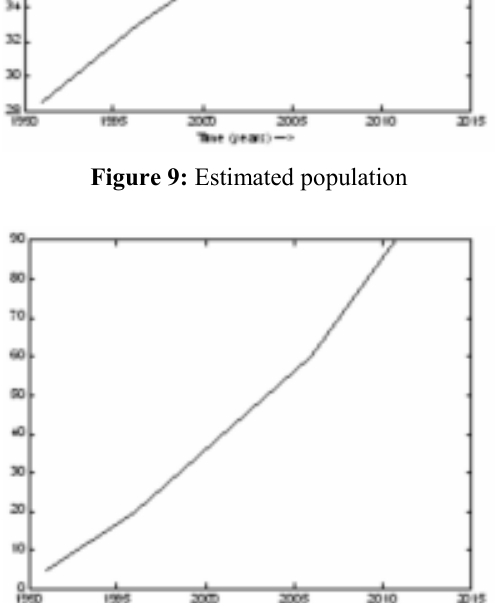
Figure 10: Awareness level among the common man